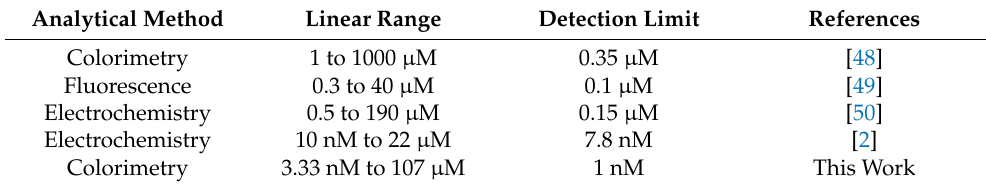
Table 1. Comparison with other reported various methods for CC detection.